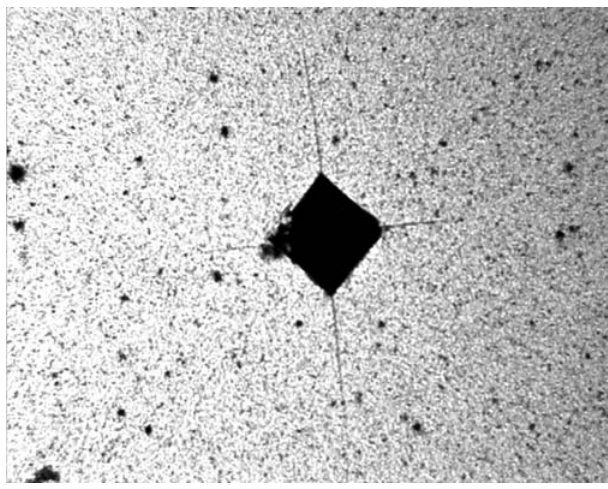
Figure 3. Indentation with radial surface cracks. Figure 4. Simulated loading and unloading cycles.